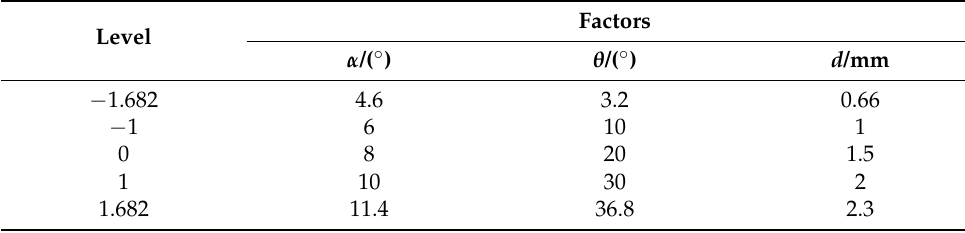
Table 2. Factors and levels of the RSM test.